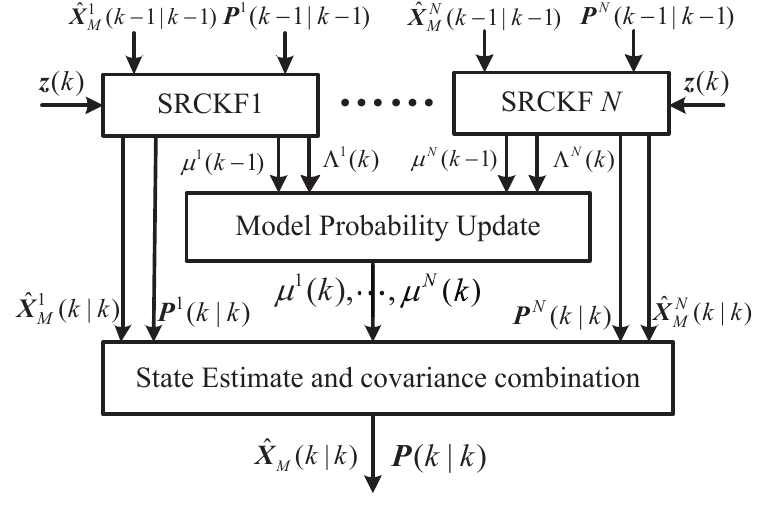
Figure 2. The structure of adaptive cooperative guidance